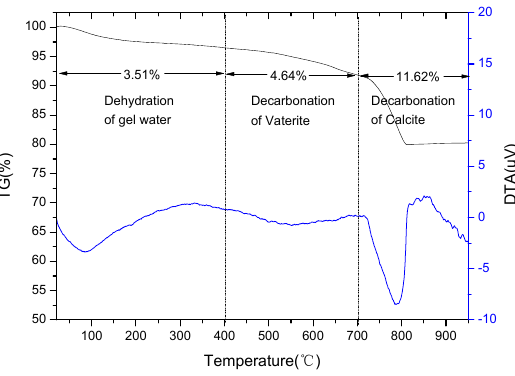
Figure 4. Thermogravimetry and Differential Thermal Analysis (TG/DTA) curves of the C 3 S 2 phase carbonated for 24 h.